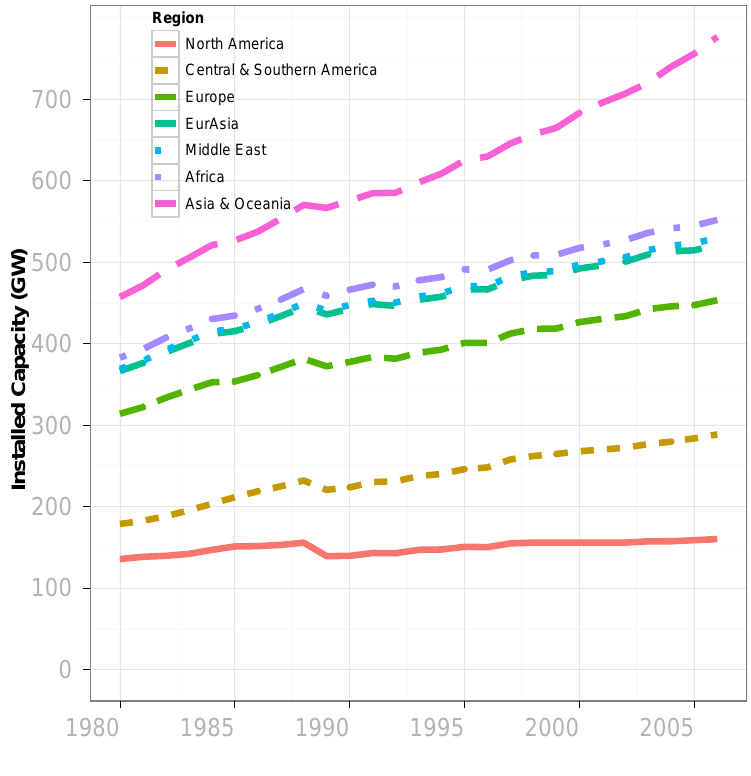
Figure 2. Trends in Global Installed Hydropower Capacities (1980–2006).